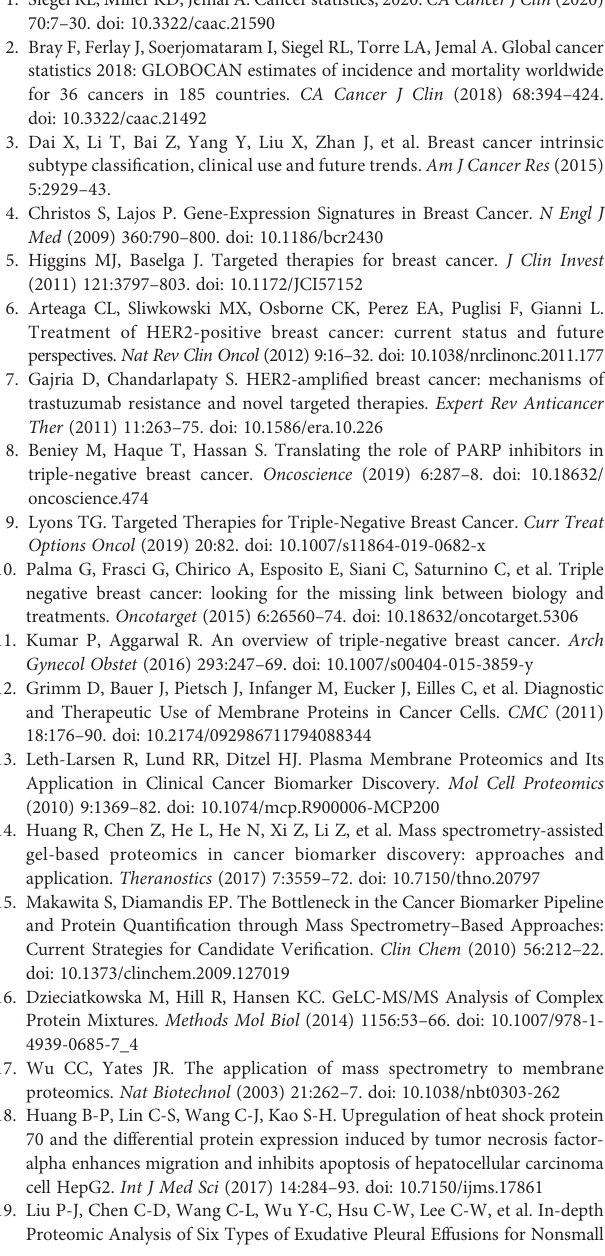
Supplementary Table 1 | Complete lists of membrane proteins found in the HCC-1954 cells and MCF-10A cells (provided as a separate excel fi le). Combined